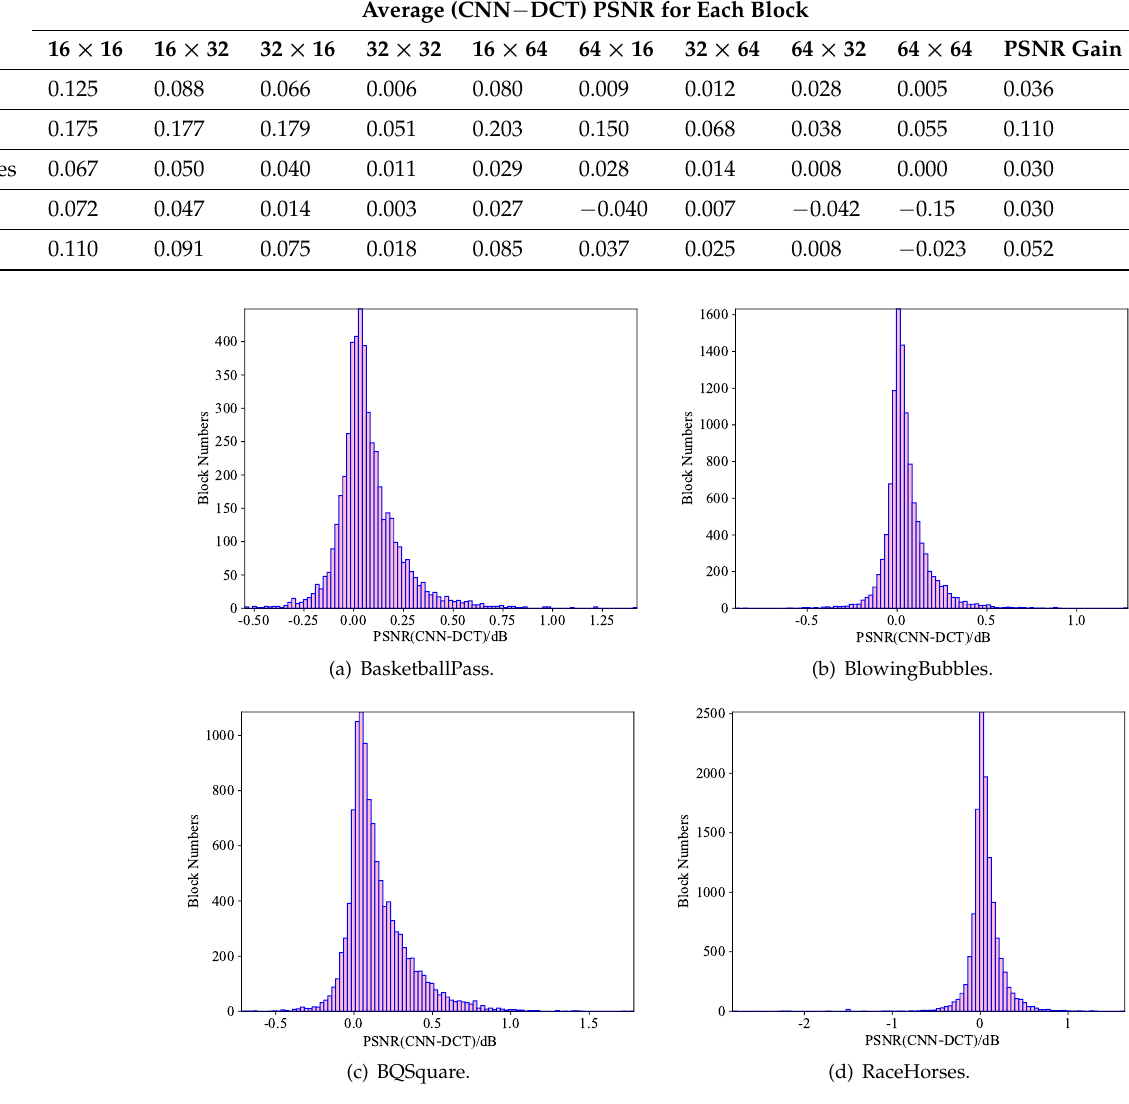
Figure 10. Number of CUs with different